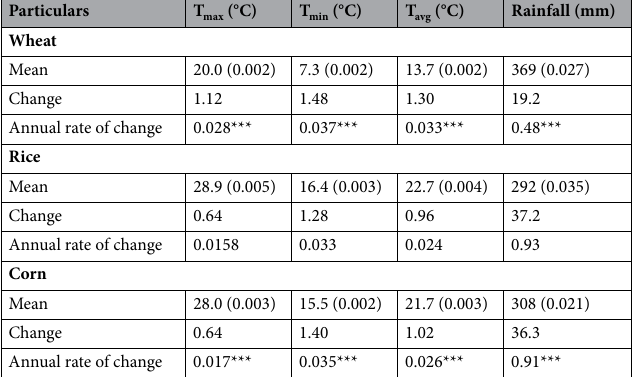
Table 4. Overall mean, change and the annual rate of change in temperature and rainfall during different crop growing seasons in the SE-US, 1980–2020. ***Denote significance at 1% level, Figures in parentheses are standard